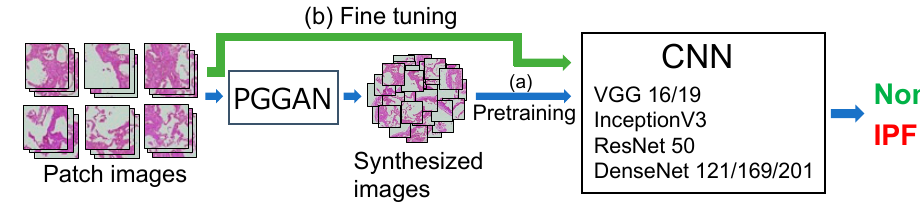
Figure 5. Two-step training of CNN.